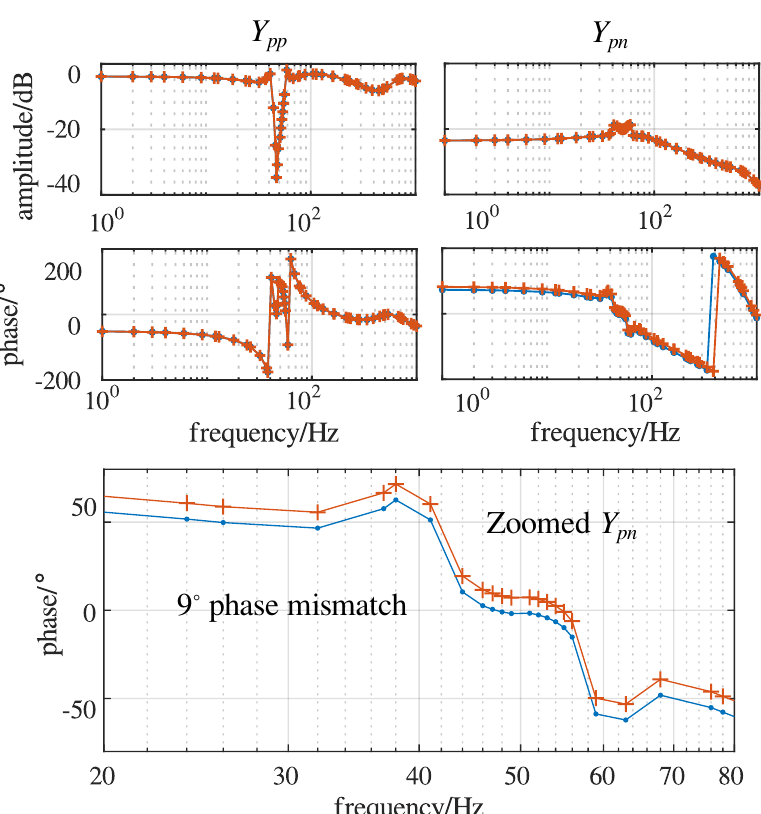
Figure 3. Impedance comparison between analytical model and simulation results. Line with dots: series impedance model obtained by connecting impedance models in local frames; Line with plus signs: series impedance model obtained in global